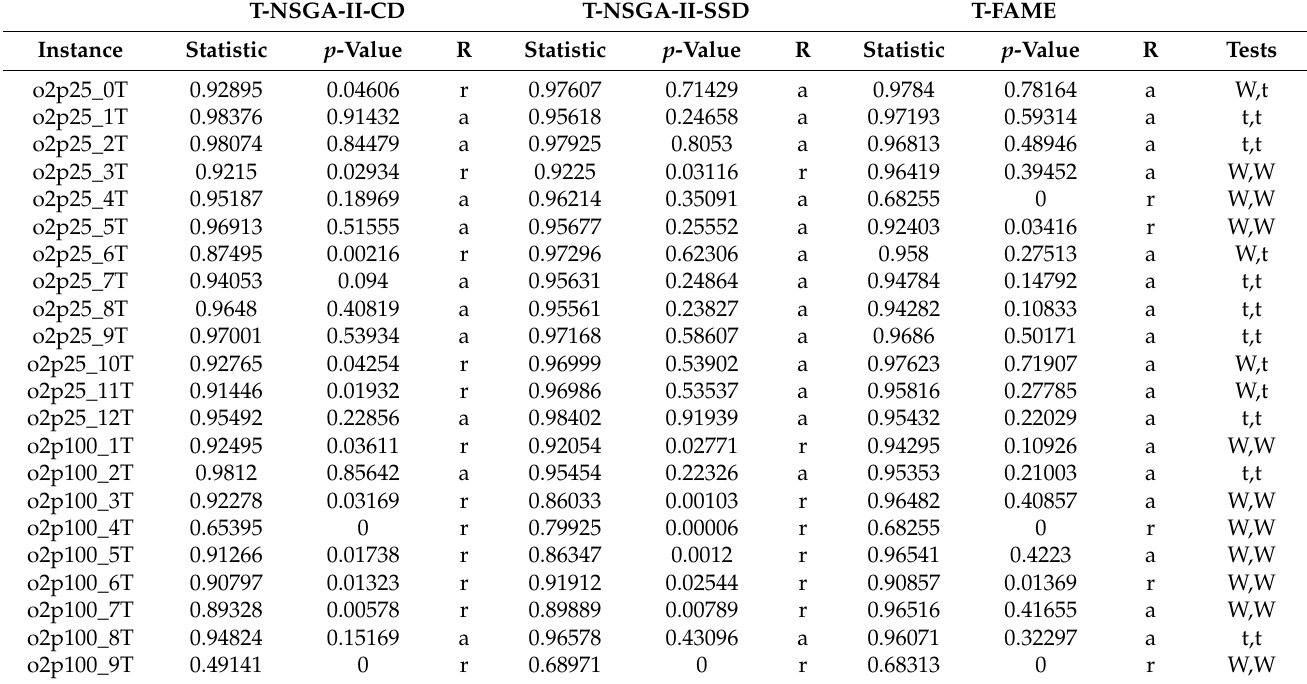
Table 8. Generalized Spread normality test, the null hypothesis is that the samples follow a normal distribution which is accepted (a) when p -value < 0.05 and rejected (r)